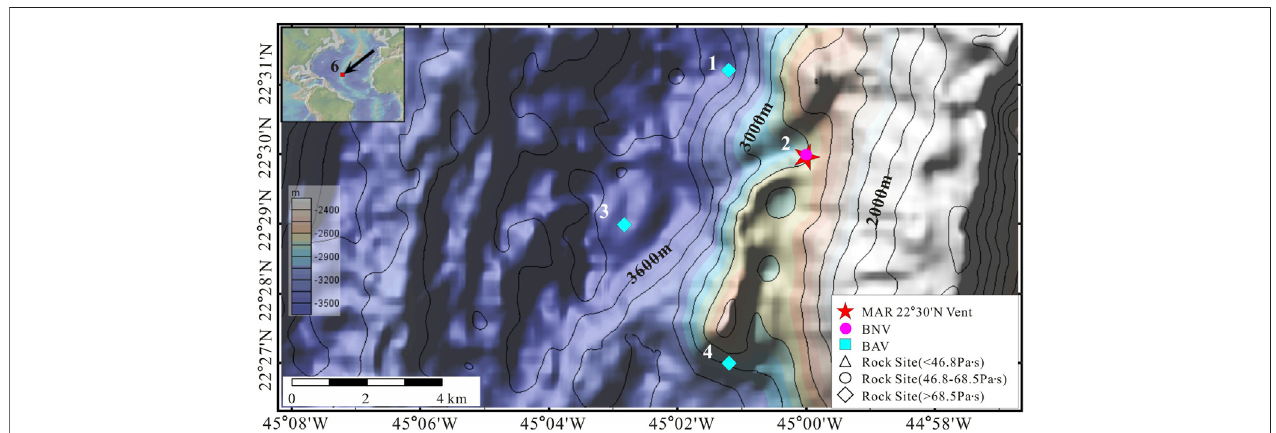
FIGURE7| BathymetricmapfromGeoMapApp,showingthelocationsoftheMAR22 ° 30 ′ Nventandthesamplesites.Blacksolidlinesarethe20 misobaths.The symbols and color bar are described in the caption of Figure 3 .